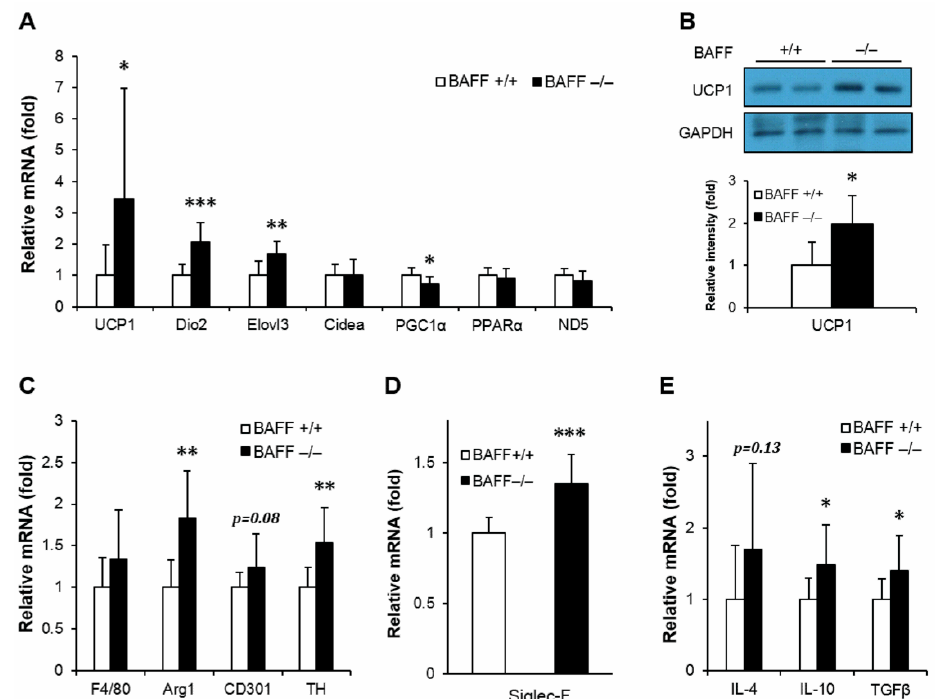
Figure 3. BAFF depletion enhances expression of genes involved in thermogenic program and alternative macrophage activation in subcutaneous adipose tissue. ( A ) Effect of BAFF deficiency on thermogenic program gene expression ( n = 9–12). Gene expression level is normalized with mRNA expression level of Arbp. ( B ) Effect of BAFF deficiency on UCP1 protein expression level ( n = 4–5). Proteins were extracted from the tissue for SDS-PAGE-immunoblot analysis. Effect of BAFF deficiency on the expression of genes involved in ( C ) M2-like macrophage activation, ( D ) mature eosinophil cell marker and ( E ) anti-inflammatory cytokine ( n = 9–12). Data represent means ± SD. * p < 0.05, ** p < 0.01, *** p < 0.001 between wild-type and BAFF -/- mice.